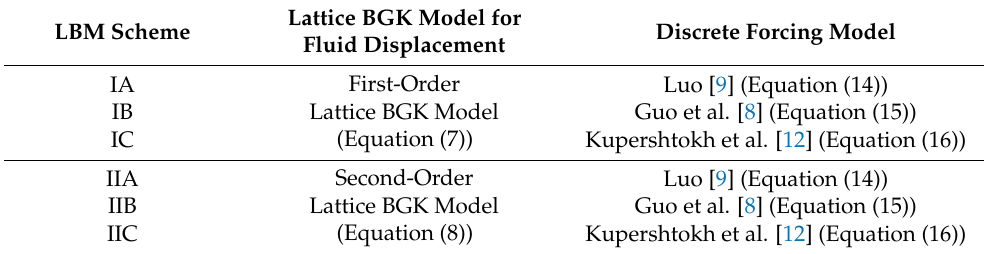
Table 1. The plausible arrangements for simulating the buoyancy-driven natural convection flow with lattice Boltzmann